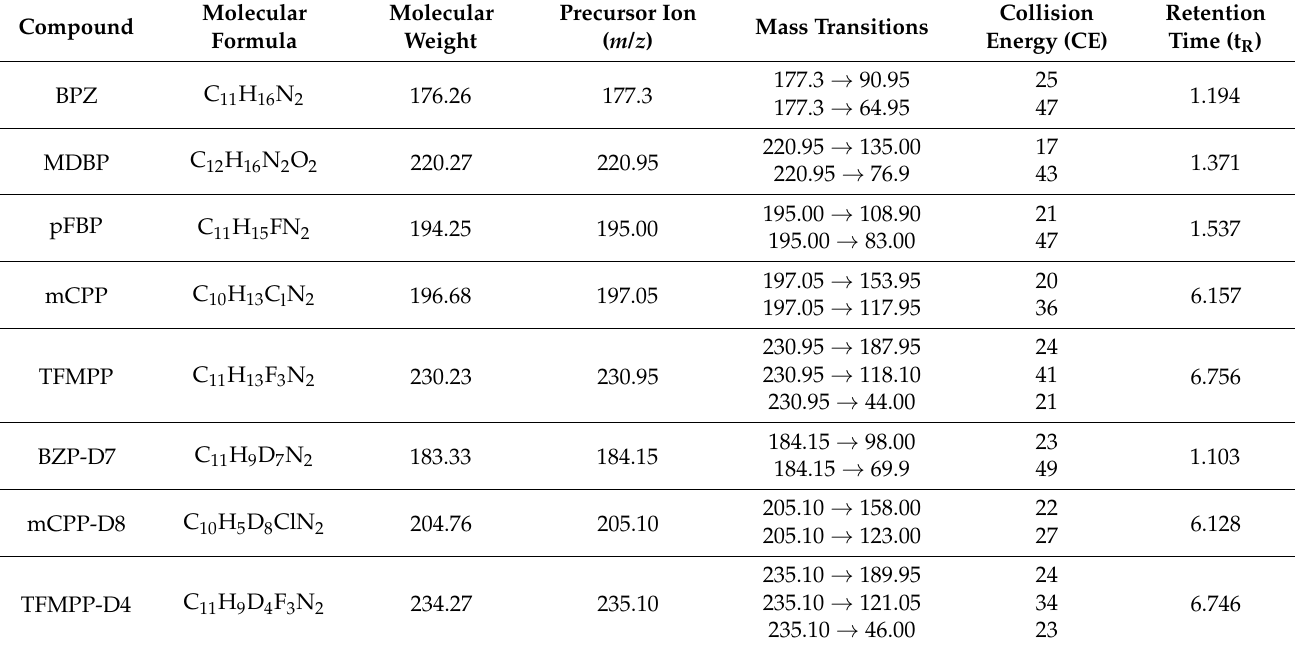
Table 1. Multiple reaction monitoring (MRM) table in the LC-MS system used.